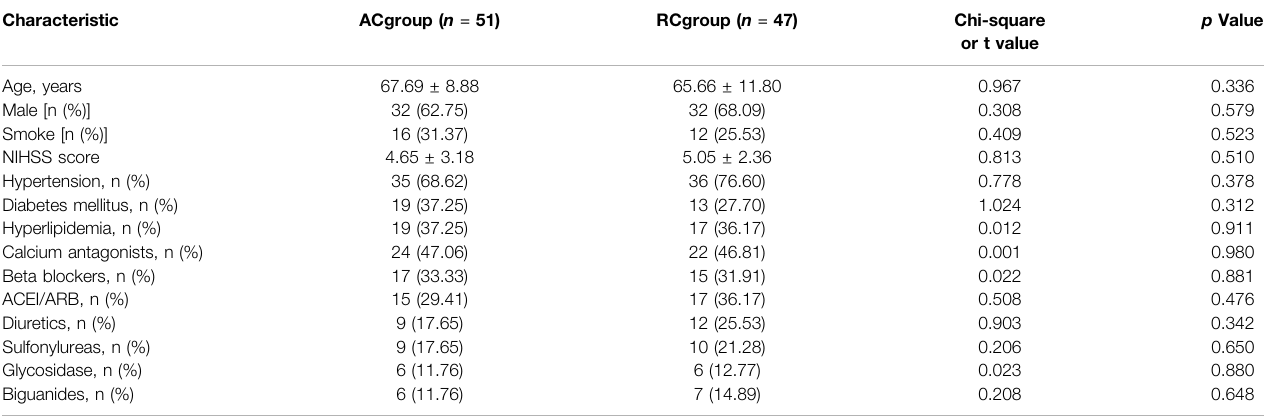
TABLE 2 | Clinical characteristics of comparison between AC and RC in CI patients. Characteristic